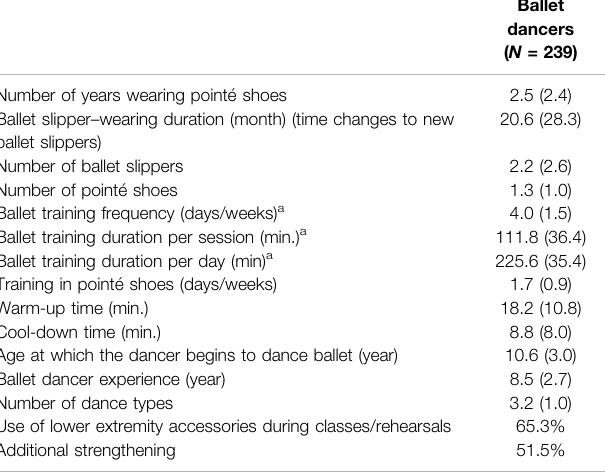
TABLE 2 | Mean (SD) and percentage of independent